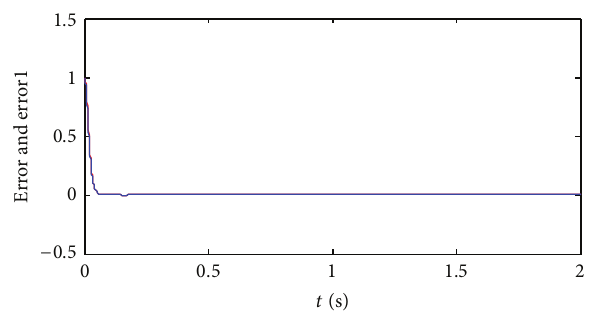
Figure 6: Error curve of PID controller based on CMAC.